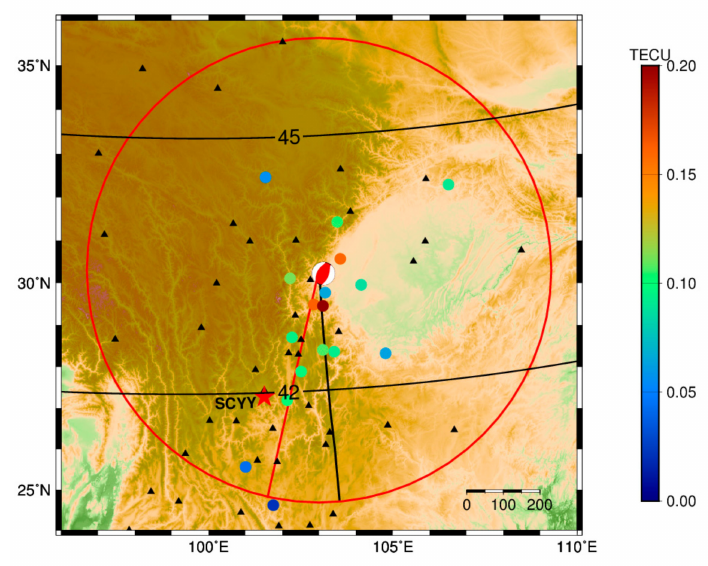
Figure 17. Sub-ionospheric point (SIP) distribution at the CID peak point. The focal sphere represents the epicenter. Dots indicate the location of SIP points. The red circle indicates the range of the seismogenic area. The red pentagram shows the reference station (SCYY) in the slant total electron content (STEC) sight where the most intense CID happens. The black triangle represents the GPS stations. The solid red line indicates the main direction of CID propagation, and the black curved and line indicates the total magnetic field intensity (unit: 103 altitude, from IGRF 12 model) and the horizontal projection of the geomagnetic line at the altitude of 277 km around